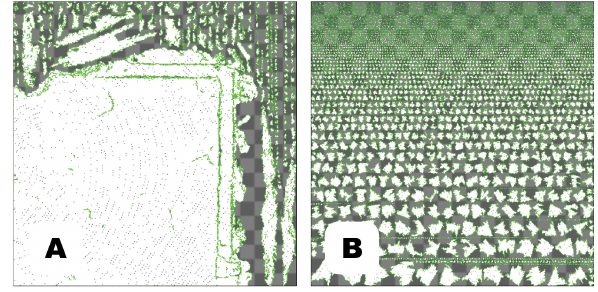
Figure 9. A, Optimized UV Map B, Automatic UV Map